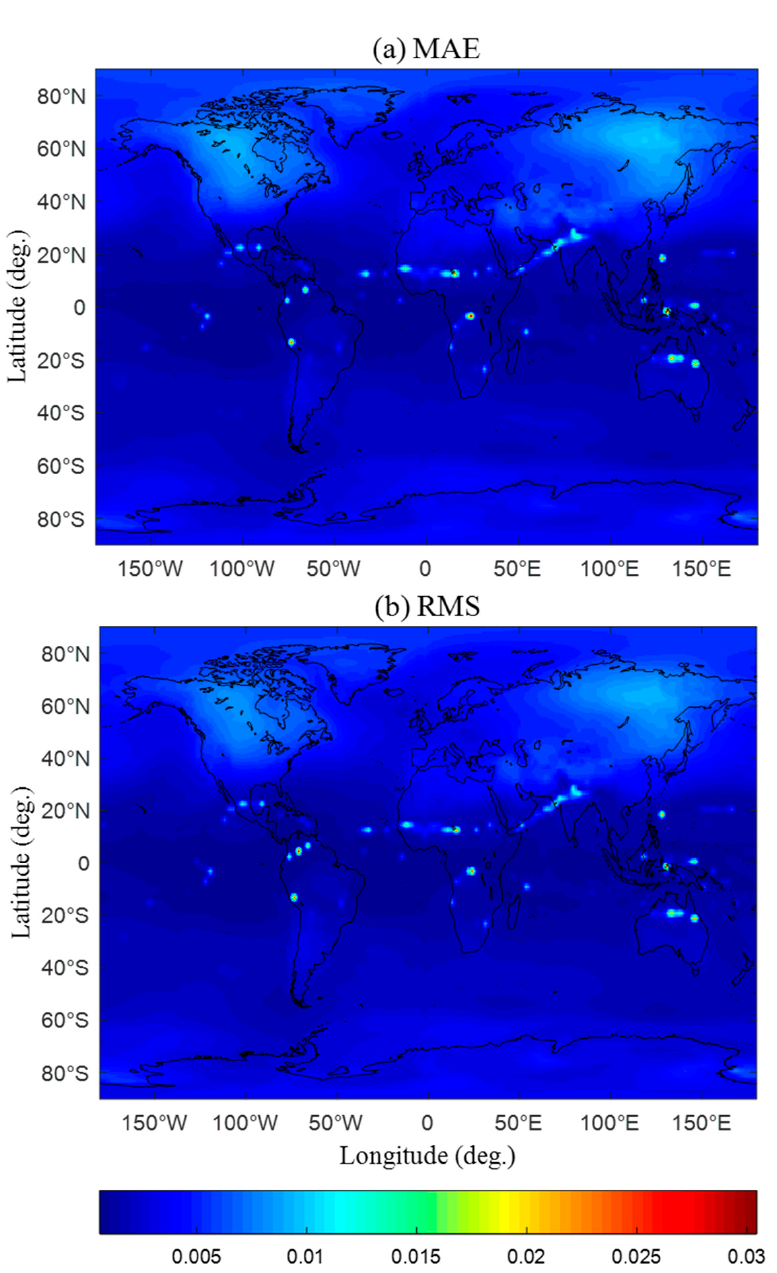
Figure 8. Distribution of the ( a ) MAE and ( b ) RMS: external accuracy testing of the G Π model when compared with that from the GGOS data of 2014.